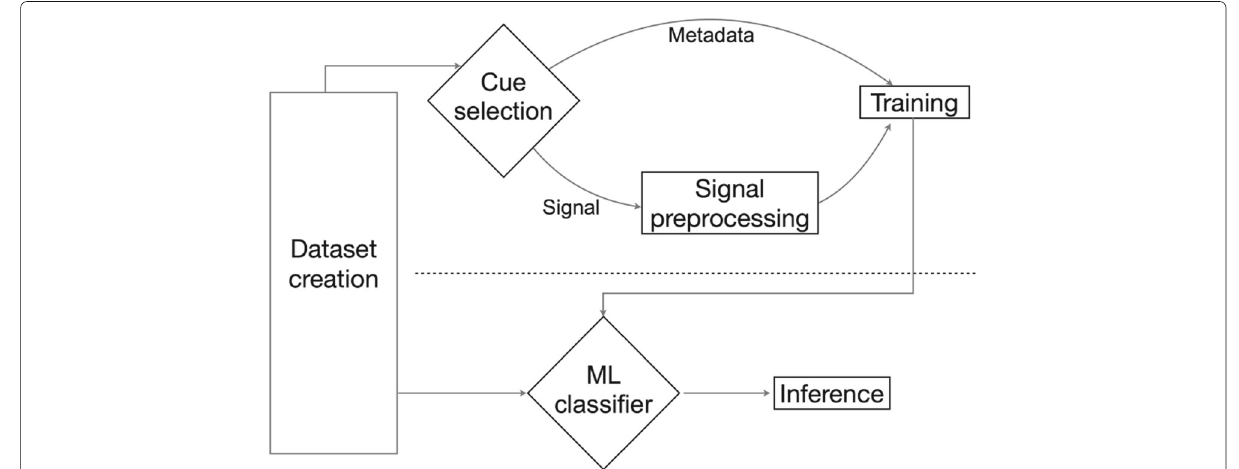
Fig. 3 Pipeline of the approaches proposed for platform provenance